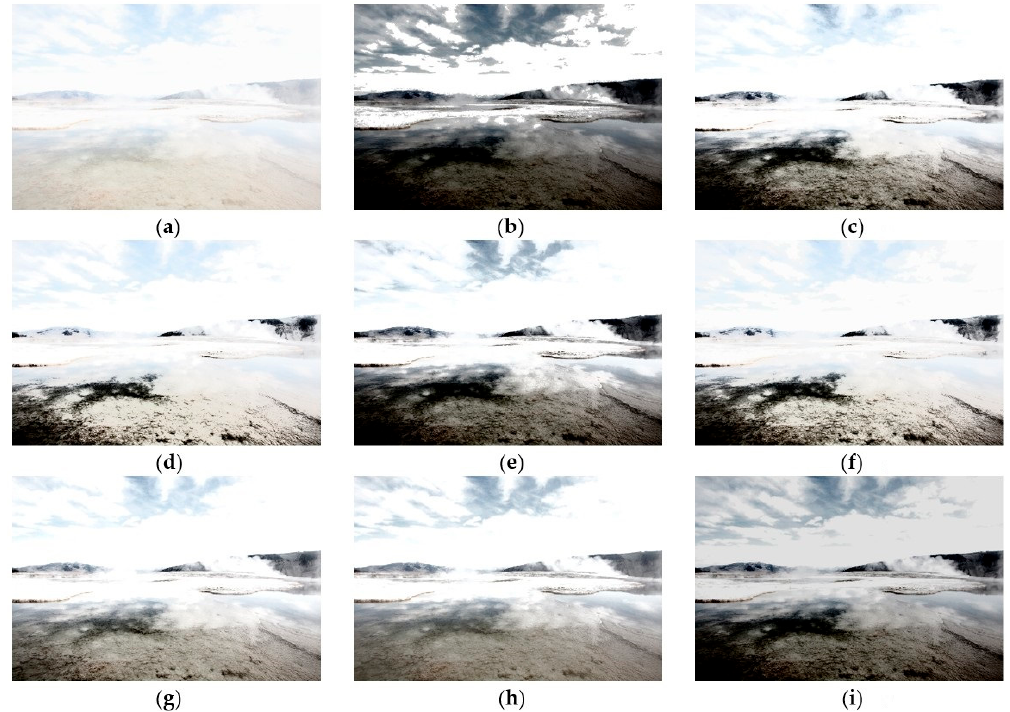
Figure 9. Results of different methods for the image Landscape [27] (image size: 960 × 640 pixels): ( a ) Original image; ( b ) HE; ( c ) BBHE; ( d ) RMSHE (r = 2); ( e ) DSIHE; ( f ) RSIHE (r = 2); ( g ) DQHEPL; ( h ) VCEA; and ( i ) CegaHE.